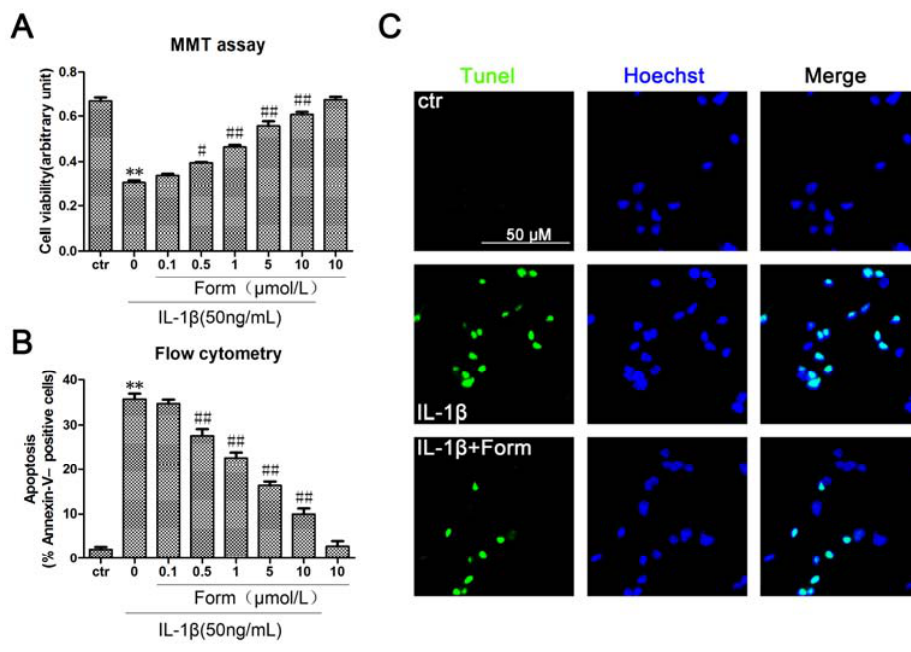
Figure 1. Formononetin inhibited IL-1 β -induced apoptosis in INS-1cells. ( A ) Cells were treated with the indicated concentrations of formononetin and IL-1 β for 24 h, analyzed by MTT assay. ( B ) Cells were stained with Annexin V-FITC and PI, analyzed by flow cytometry. Data are expressed as % of Annexin V-FITC- positive and PI-negative cells (early stage of apoptosis). ( C ) Tunel staining of apoptotic cells, IL-1 β (50 ng/mL) and formononetin (1 μ mol/L). Apoptotic cells were marked with green fluorescence, the nuclei of cells are stained by blue fluorescence. Values are the means ± SD (n = 3) of three individual experiments. * p < 0.05, ** p < 0.01 vs . ctr (DMSO); # p < 0.05, ## p < 0.01 vs . group treated with IL-1 β excluding